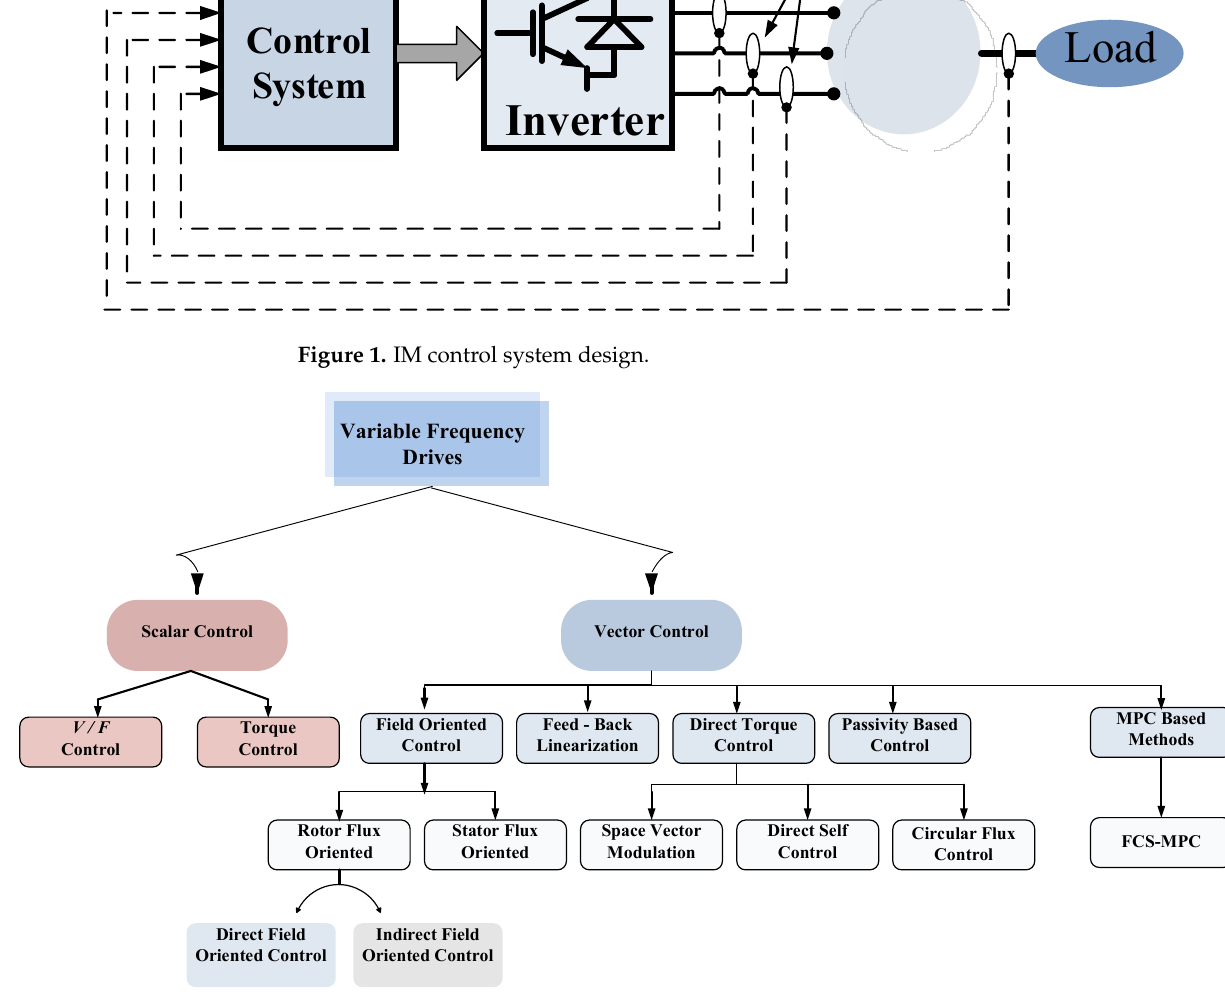
Figure 2. Classification of the VFD methods.